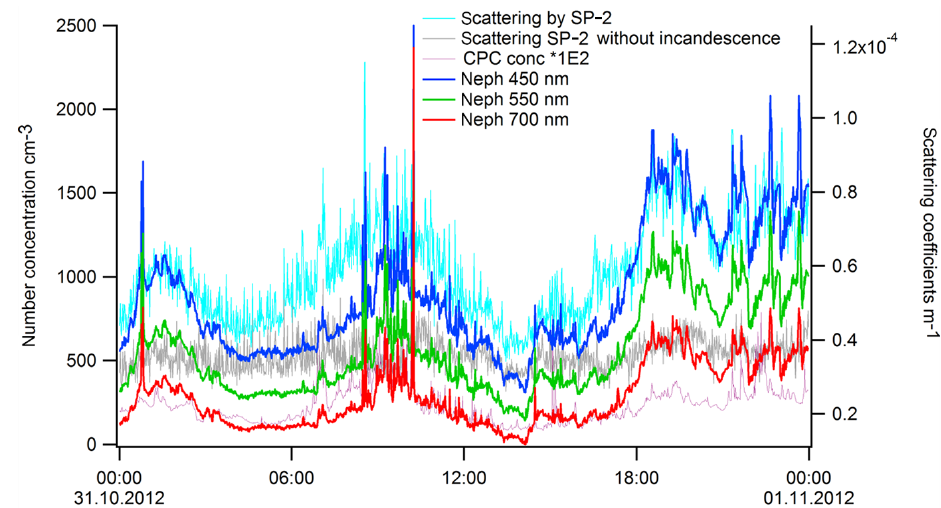
Figure 9. Number concentrations measured by CPC (purple line), SP-2 for all scattering particles (gray line), and scattering particles without incandescence (light blue line) compared to scattering coefficients from the nephelometer at three